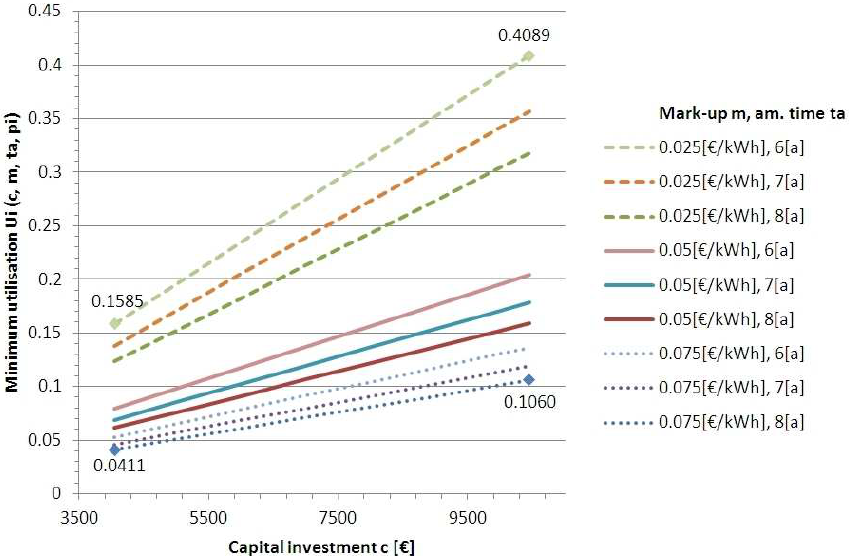
Figure 4. Minimum utilisation U i of a charging station for charging power p i =22kW and different combinations of parameters c, m and t